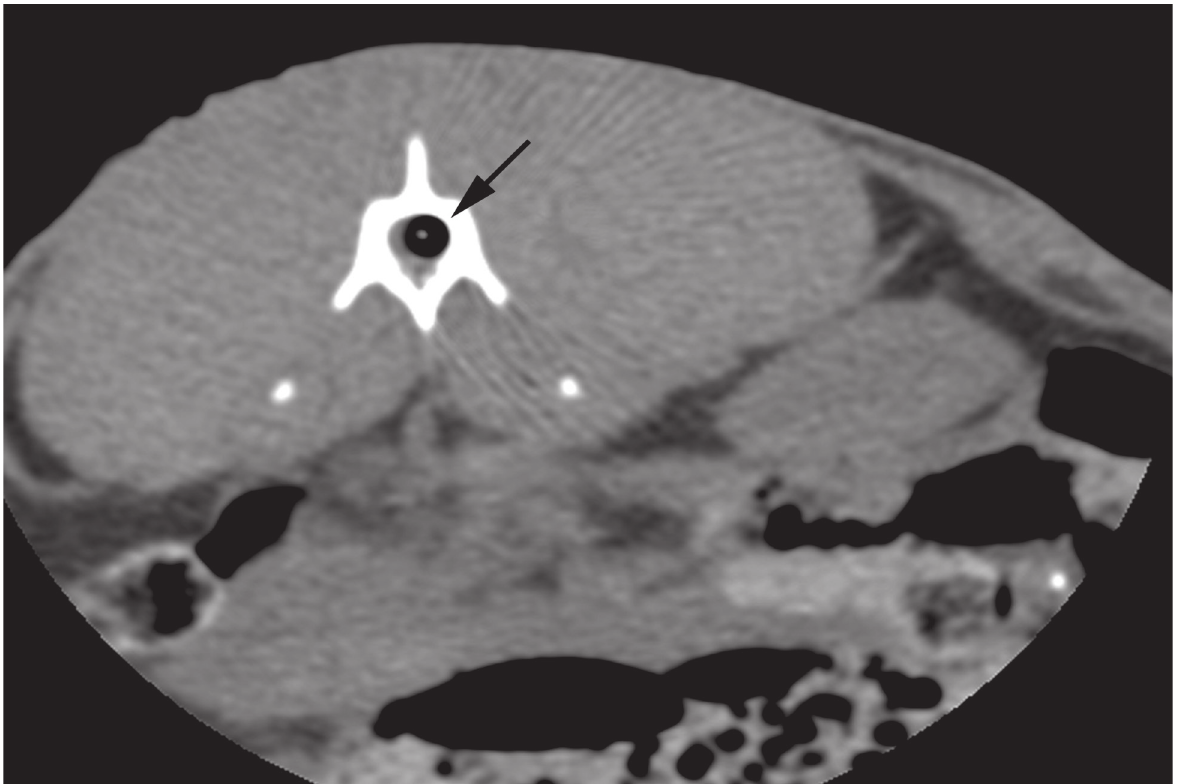
Figure 4 - Tomographic image showing catheter positioning. Spinal canal with the presence of the inflated cuff (white arrow) Source: Personal archive,